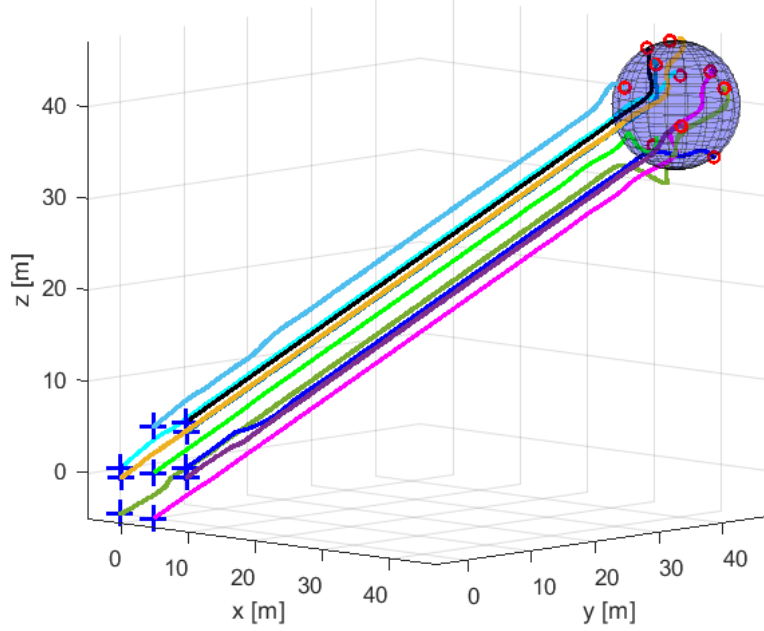
Figure 2. UAV swarm converging to the spherical formation shapes in